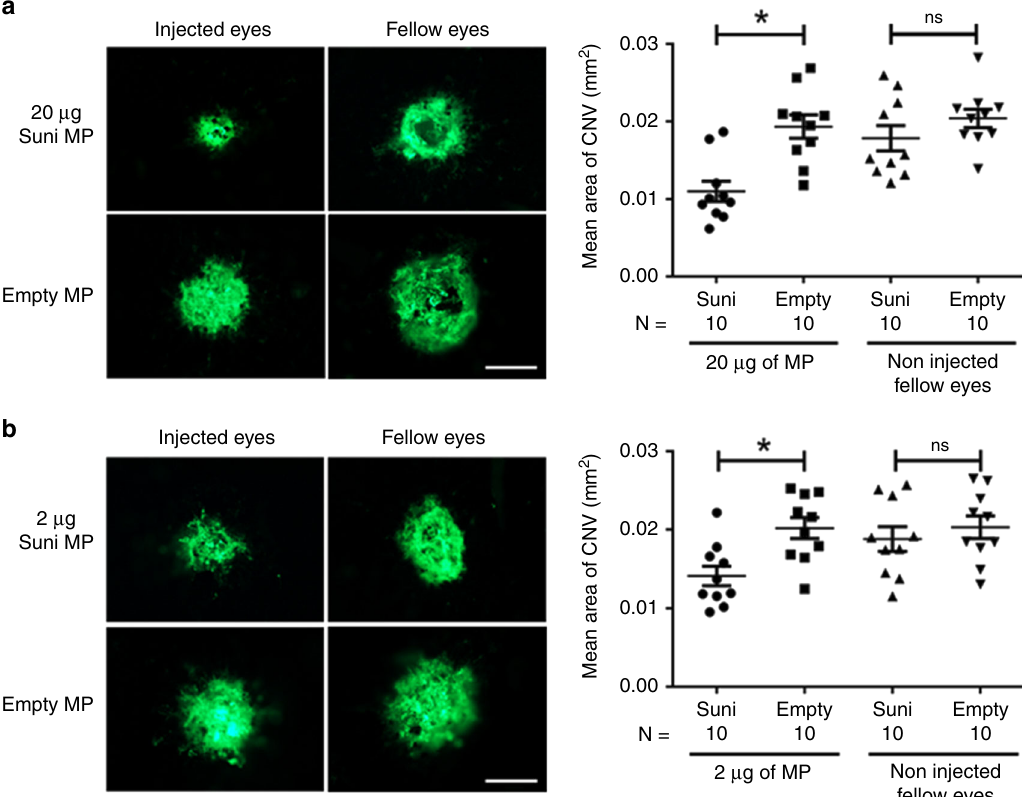
Fig. 3 Subconjunctival injection of sunitinib MPs suppresses type 2 choroidal NV. C57BL/6 mice received a 2 µ l subconjunctival injection of microparticles (MP) containing 20 or 2 µ g of sunitinib (Suni) or empty MP in one eye and no injection in the fellow eye. At 1 week after injection, Bruch ’ s membrane was ruptured by laser photocoagulation at three locations in each eye. One week after laser, mice were euthanized and choroidal fl at mounts were stained with FITC-labeled GSA lectin and the area of choroidal neovascularization (CNV) was measured at Bruch ’ s membrane rupture sites by an investigator masked with regard to treatment. The three values from each eye were averaged to give a single experimental value. The mean (±SEM) area of CNV was signi fi cantly less in eyes injected with MP containing 20 µ g ( a ) or 2 µ g ( b ) sunitinib vs. those injected with empty MP, but there was no signi fi cant difference between fellow eyes for each group. * p < 0.05 for difference from all other groups by Kruskal Wallis test followed by Dunn ’ s test. Bar = 100 µ m. Source data are provided as a Source Data fi